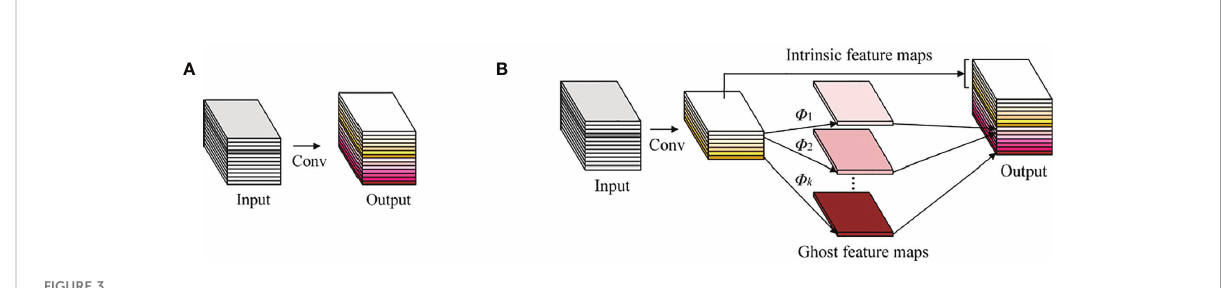
FIGURE 3 Comparison diagram between the convolutional layer and the Ghost Module: (A) The convolutional layer; (B) The Ghost